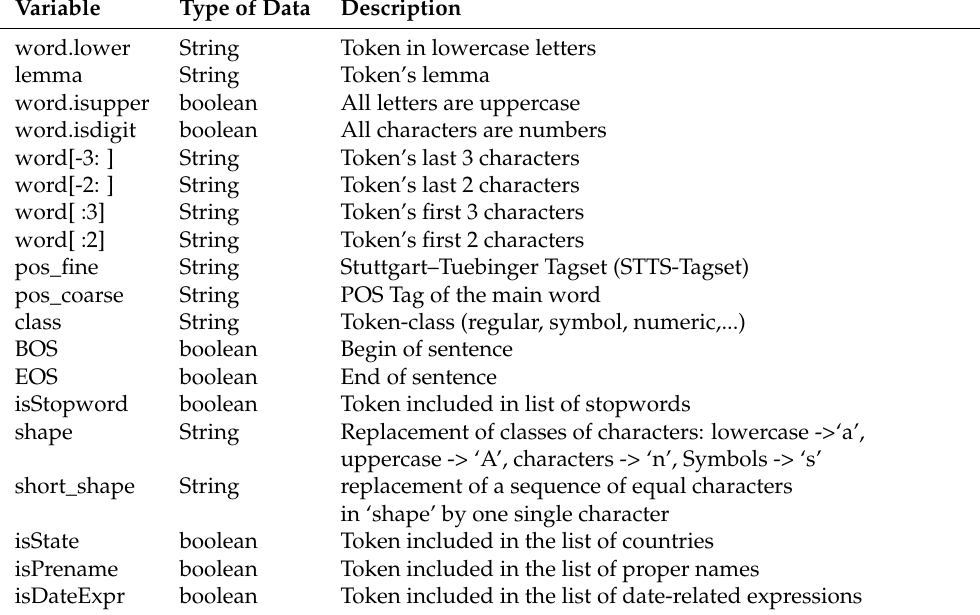
Table 2. Set of token semantic and syntactic features used in the CRF